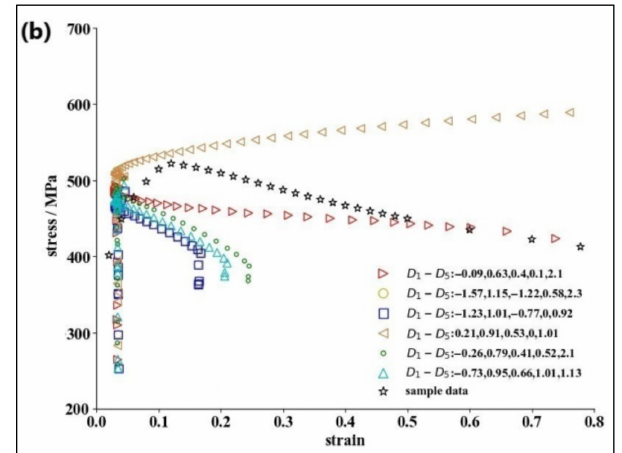
Figure 10. The stress–strain curve of AlFeSi phase with D 1 – D 5 : ( a ) strain rate of 1000 s –1 , temperature of 20 ◦ C; ( b ) strain rate of 0.01 s –1 , temperature of 500 ◦ C.